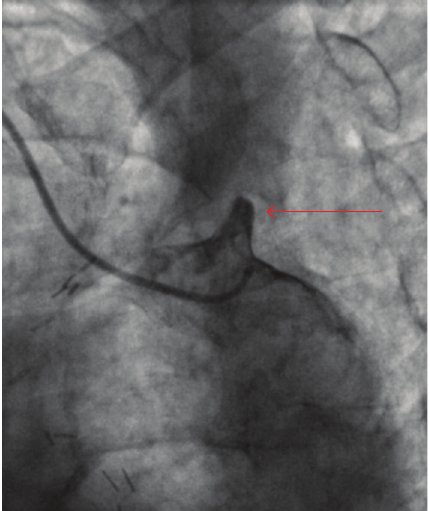
Figure 3: Selective angiogram of the origin of the occluded left sub- clavian artery (arrow).